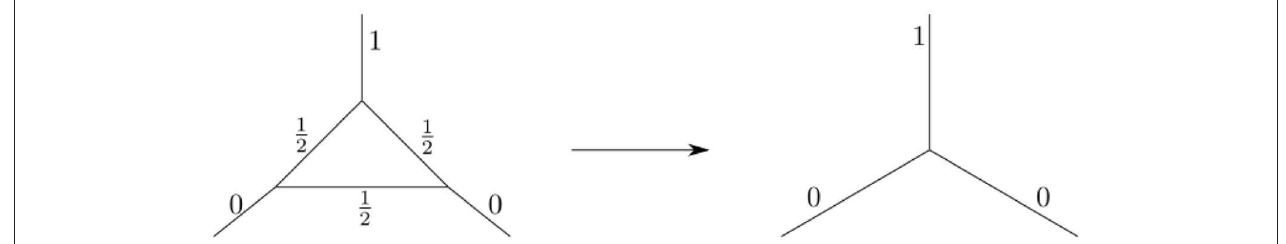
FIGURE 12 | Gauss constraint violations under coarse graining [for SU(2)]: we can define an effective vertex by summing over the SU(2) representations associated to the inner edges. The configuration on the left is allowed by the coupling rules, thus the effective vertex on the right is allowed. However, this configuration is forbidden by SU(2) coupling